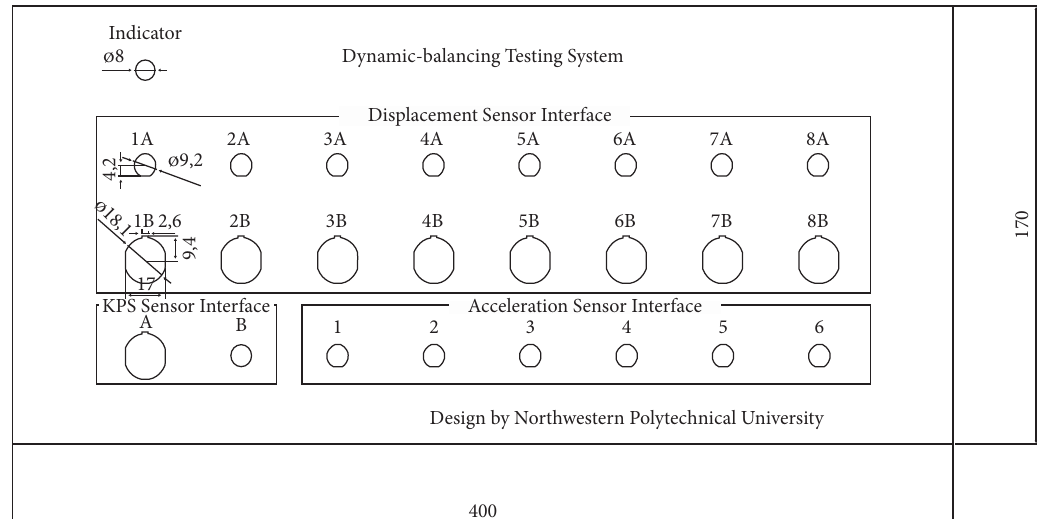
Figure 4: The front layout of the hardware